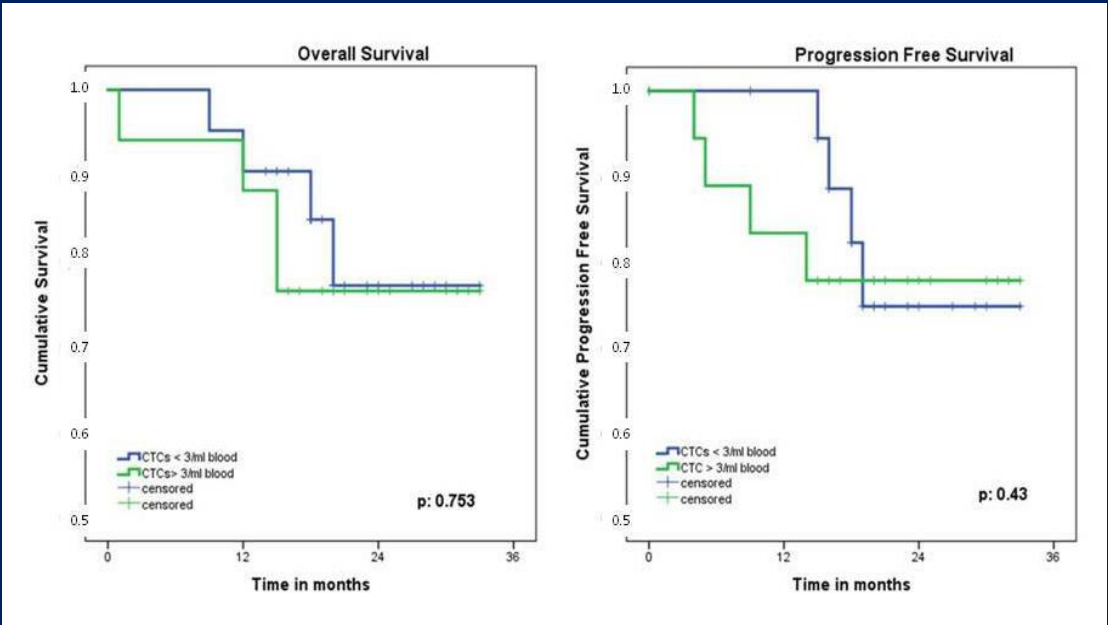
Figure 7. Kaplan – Meier showing OS and PFS according to CTCs count. OS, overall survival; PFS, Figure 7. Kaplan–Meier showing OS and PFS according to CTCs count. OS, overall survival; PFS, progression-free survival; CTCs, circulating tumor cells. progression-free survival; CTCs, circulating tumor